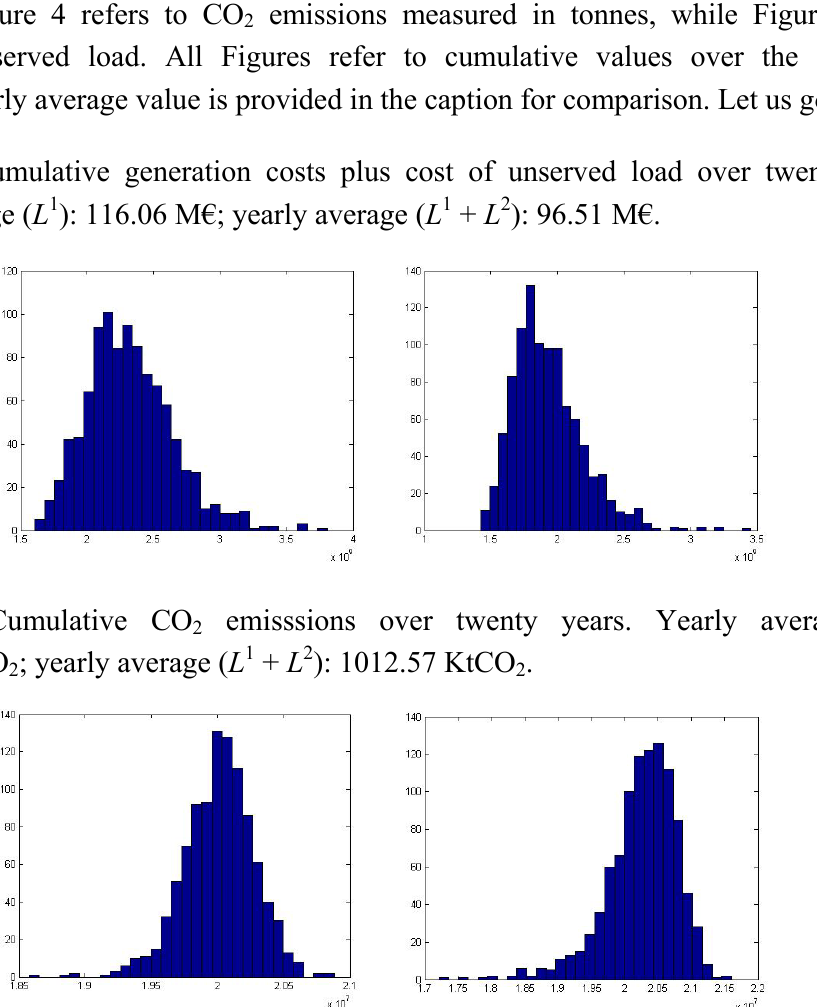
Figure 3. Cumulative generation costs plus cost of unserved load over twenty years.